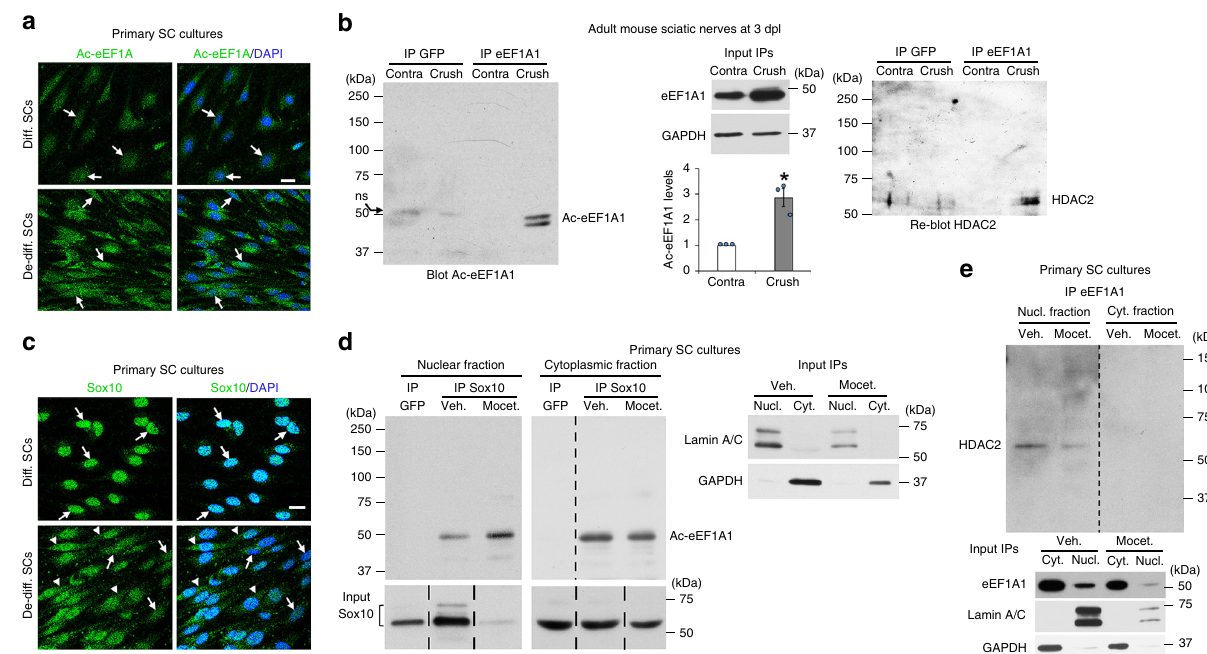
Fig. 2 Sox10 re-localizes to the cytoplasm with Ac-eEF1A1 in de-differentiated SCs. Immuno fl uorescence of Ac-eEF1A ( a ) and Sox10 ( c ), and DAPI (nuclei) labeling in differentiated and de-differentiated SCs. b Immunoprecipitation (IP) of eEF1A1 or GFP (control) carried out on the same pool of two adult mouse crushed or unlesioned contralateral sciatic nerves at 3dpl and Western blot of Ac-eEF1A followed by HDAC2. EEF1A1 and GAPDH Western blots on lysates show the input, n = 3 (6 animals). The graph shows the quanti fi cation of Ac-eEF1A levels (measured on a longer exposure to obtain a value for the contra IP eEF1A1) normalized to eEF1A1 input. Data are presented as mean values ± SEM. Paired two-tailed Student ’ s t -tests, p value = 0.03376. IP Sox10 or GFP ( d ) or IP eEF1A1 ( e ) followed by Ac-eEF1A ( d ) or HDAC2 ( e ) Western blot in nuclear and cytoplasmic fractions of primary SCs cultured under de-differentiating conditions and treated with the HDAC1/2 inhibitor mocetinostat or its vehicle for 3 days. Lamin A/C (nuclear marker), GAPDH (cytoplasmic marker), Sox10 and eEF1A1 Western blots on lysates used for IP show the inputs. Dashed lines indicate that samples were run on the same gel but not on consecutive lanes. Arrows point to SC nuclei ( a , c ) and arrowheads ( c ) to SC cytoplasm. a – e Representative images of 3 independent experiments are shown. Scale bars: 10 µ m. Source data are provided as a Source Data fi